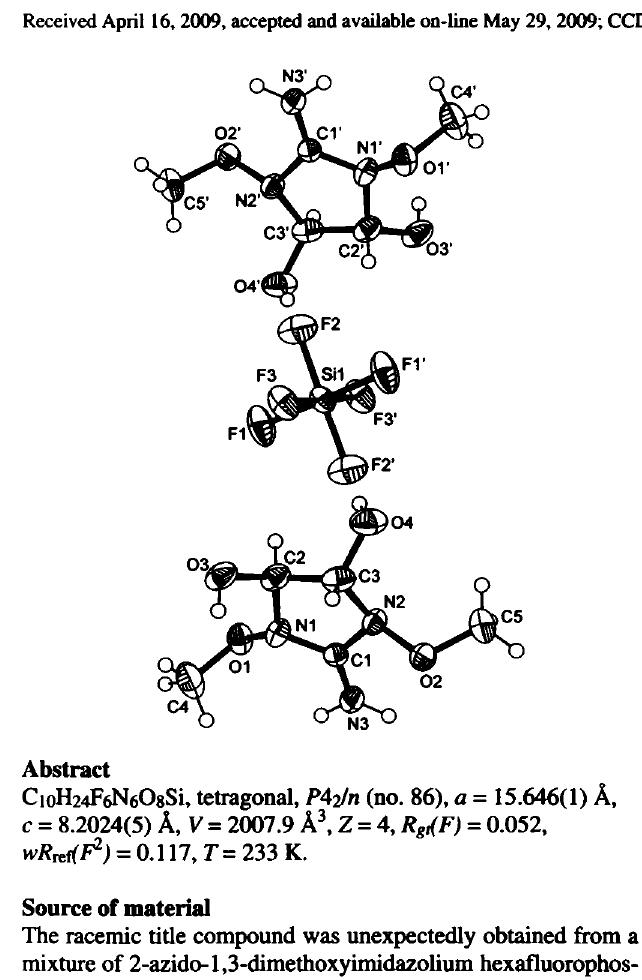
Table 2. Atomic coordinates and displacement parameters (in Â 2